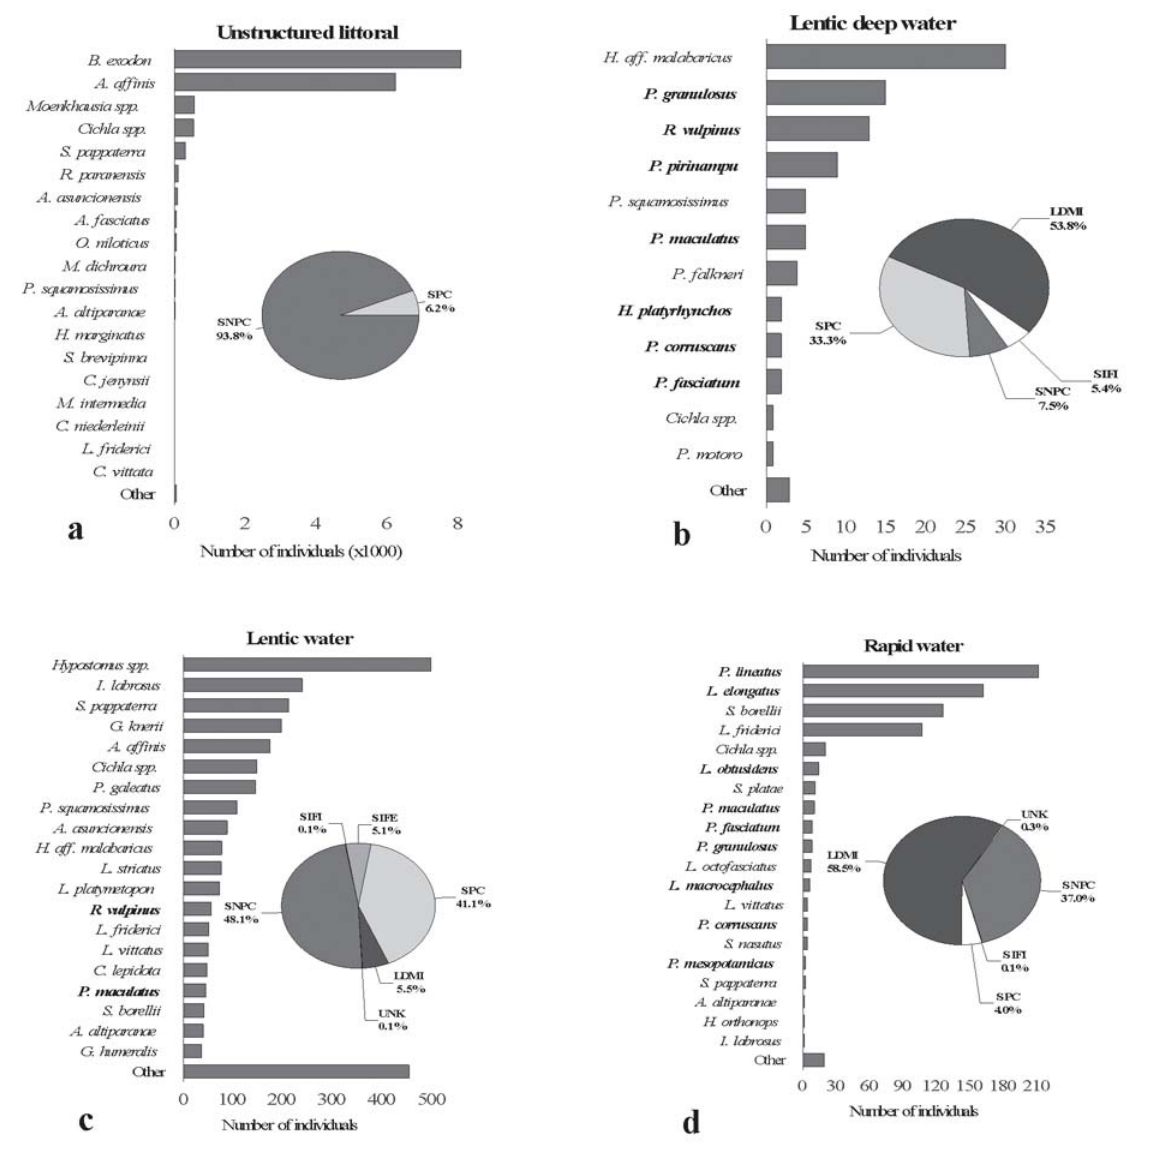
Fig. 4. Number of individuals of the principal species, according to reproductive strategy by different biotope: LDMI (long-distance migratory species), SNPC (sedentary with no parental care), SPC (sedentary with parental care), SIFE (sedentary with internal fertilization and external development), SIFI (sedentary with internal fertilization and internal development) and UNK